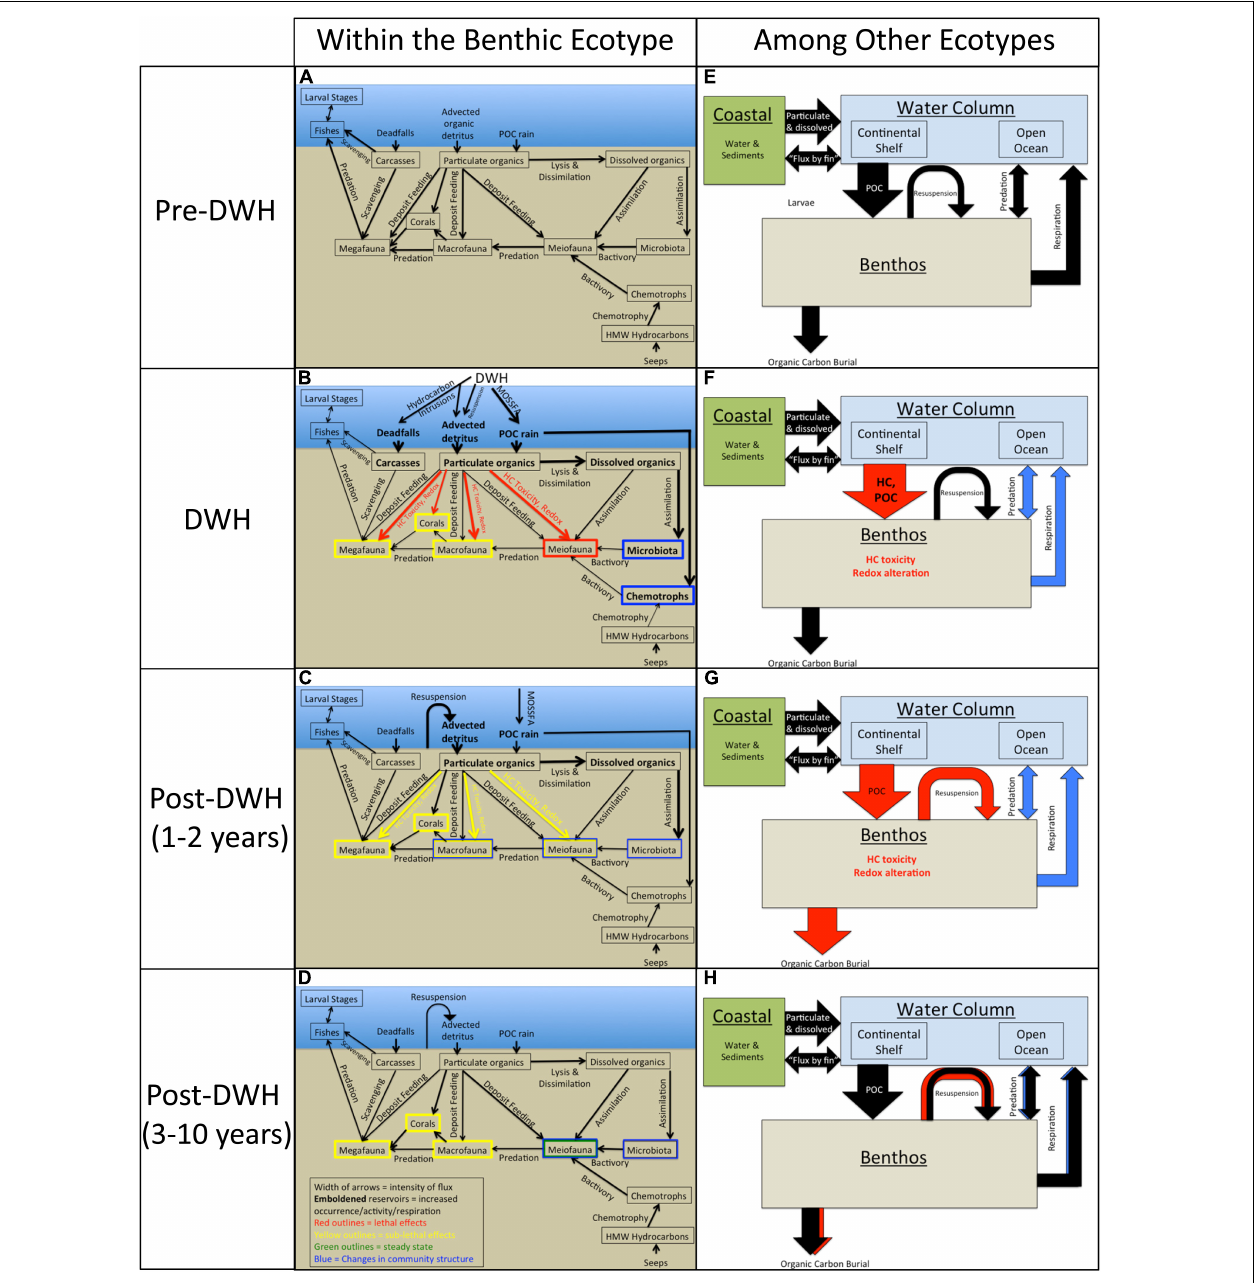
FIGURE 2 | A conceptual model of the benthic ecotype including the major groups, the interaction amongst the groups the interaction between groups and environmental controls, food sources and/or stressors [e.g., hydrocarbon (HC) toxicity], and processes within the benthic ecotype (panels A–D ) and among the other ecotypes (panels E–H ) for four time periods: (1) pre-DWH, (2) during DWH, (3) post-DWH 1–2 years, and (4) post-DWH 3–10 years. The pre-DWH model is modified from Rowe and Kennicutt (2009). Processes not discussed in the text are: “flux by fin” (Nelson et al., 2012), high molecular weight (HMX) hydrocarbons from petroleum seeps (MacDonald et al.,